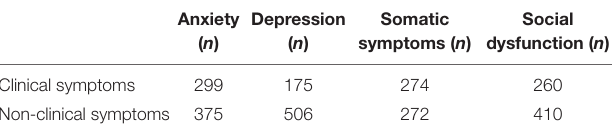
TABLE 1 | Self-reported mental health symptoms as measured by GHQ. Clinical symptoms Non-clinical symptoms